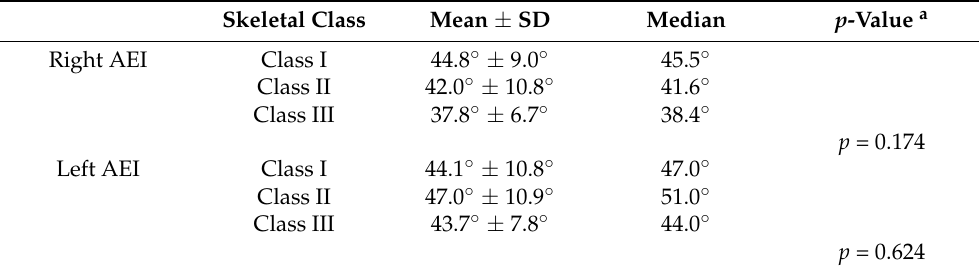
Table 3. Kruskal–Wallis Test for right and left